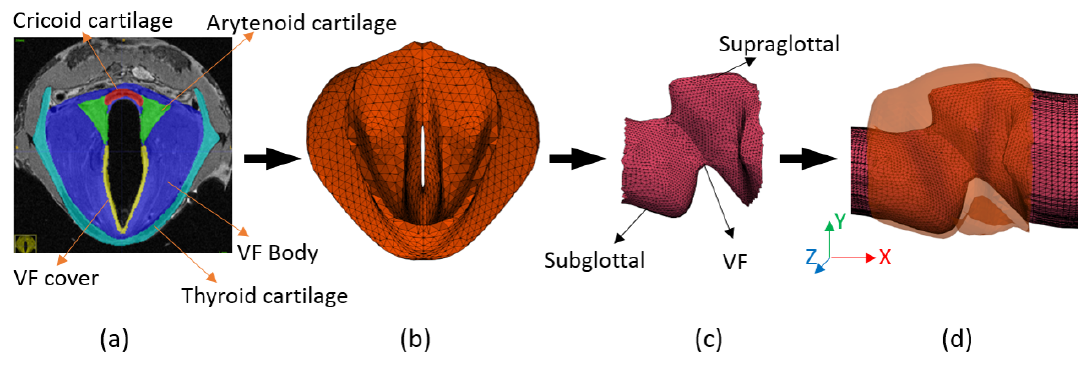
Figure 2. ( a ) Manual segmentation of the MRI data for the vocal fold (VF). ( b ) Reconstructed 3D VF mesh model. ( c ) Extracted lumen from the 3D larynx. ( d ) Extensions added in both directions as the flow domain (only a small portion of inlet and outlet are shown).